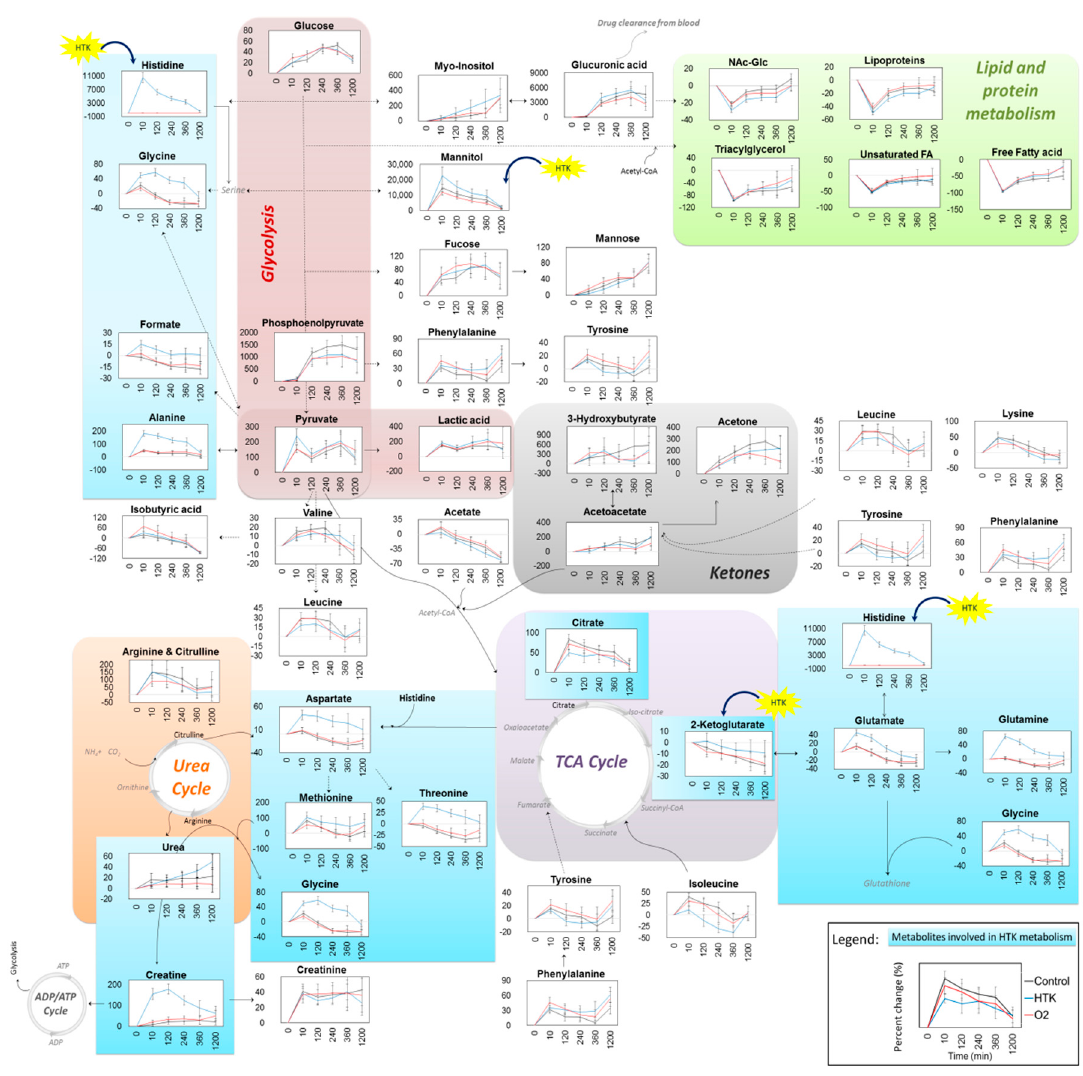
Figure 4. Overview of plasma metabolite changes as a consequence of the surgical procedure and treatment received (black, standard CPB; red, oxygenated blood; blue, HTK solution). To avoid baseline effects due to patient heterogeneity, each patient is considered to be their own control and data is presented as percent change from pre-CPB values in each individual patient; i.e., (postCPB − preCPB)/preCPB ∙ 100. Results are presented as means and 95% confidence intervals of the percent change. Metabolites directly affected by the HTK solution are highlighted in blue boxes. HTK solution contains histidine, tryptophan, 2-ketoglutarate, and mannitol, and these metabolites are marked with yellow HTK symbols, with the exception of tryptophan, which was not detected on the NMR spectra.